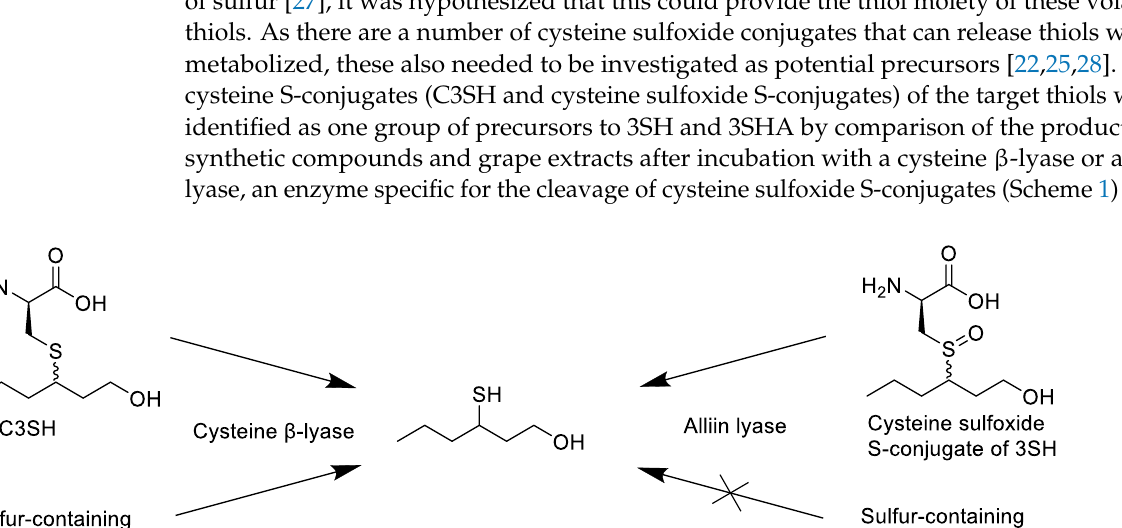
Figure 2. 3SH is released from non-volatile precursors, including 3-S-cysteinylhexan-1-ol (C3SH) and 3-S-glutathionylhexan-1-ol (G3SH), during fermentation, and 3SH can then be acetylated via yeast to 3SHA.